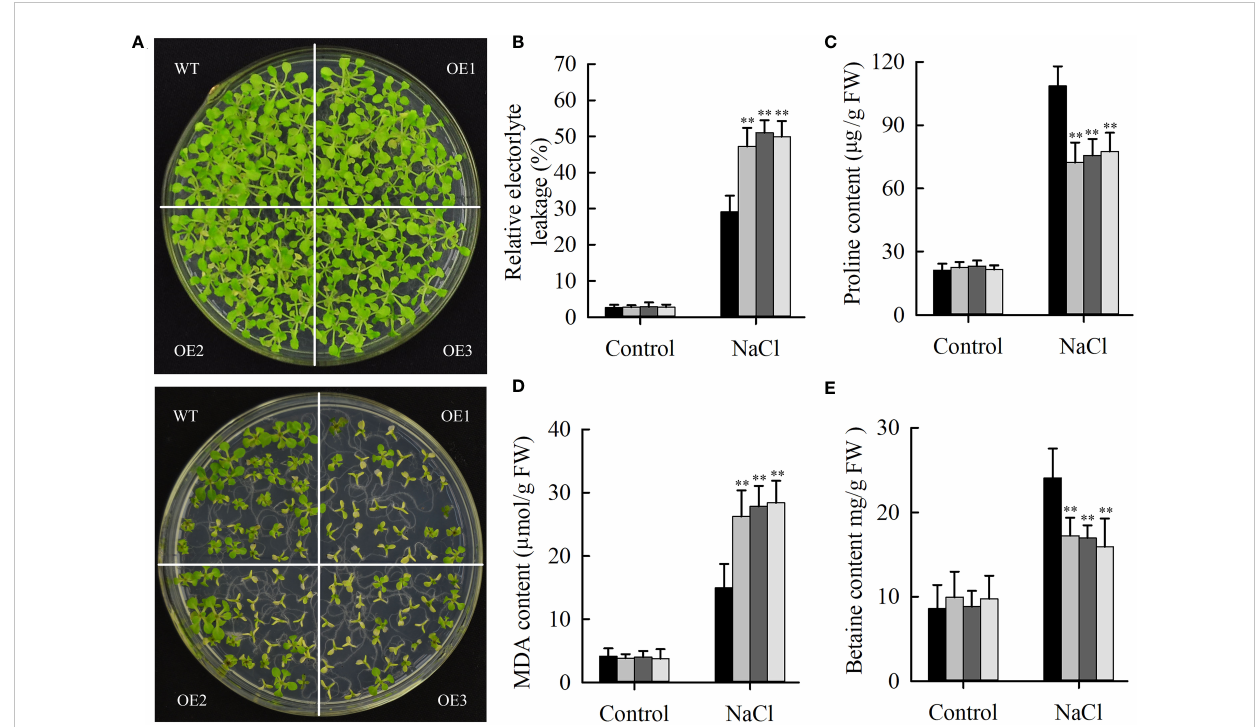
FIGURE 6 Phenotypic and physiological indicators analysis of wild-type and JcHDZ21 transgenic plants growth in control and salt stress conditions. (A) Phenotypes of wild-type and JcHDZ21 transgenic plants at 25 days growth in control and salt stress conditions. (B) Relative electrolyte leakage of leaves of wild-type and overexpressing plants after stress treatment and under non-stress conditions. (C) Proline content of leaves of wild-type and overexpressing plants after stress treatment and under non-stress conditions. (D) MDA content of leaves of wild-type and overexpressing plants after stress treatment and under non-stress conditions. (E) Betaine content of leaves of wild-type and overexpressing plants after stress treatment and under non-stress conditions. Data in (B – E) : means of n = 21 ± SD from three independent experiments, asterisks above the bars indicate signi fi cant differences from wild-type controls at p < 0.01according to Duncan ’ s multiple range